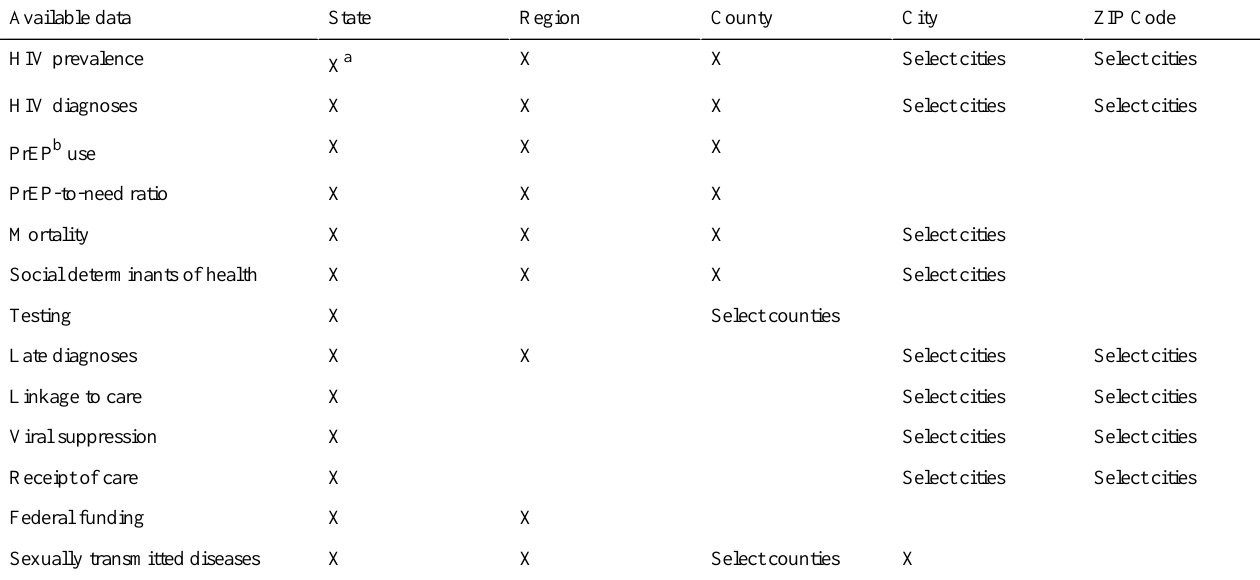
Table 2. Availability of data by geographic level from the AIDSVu Project, July